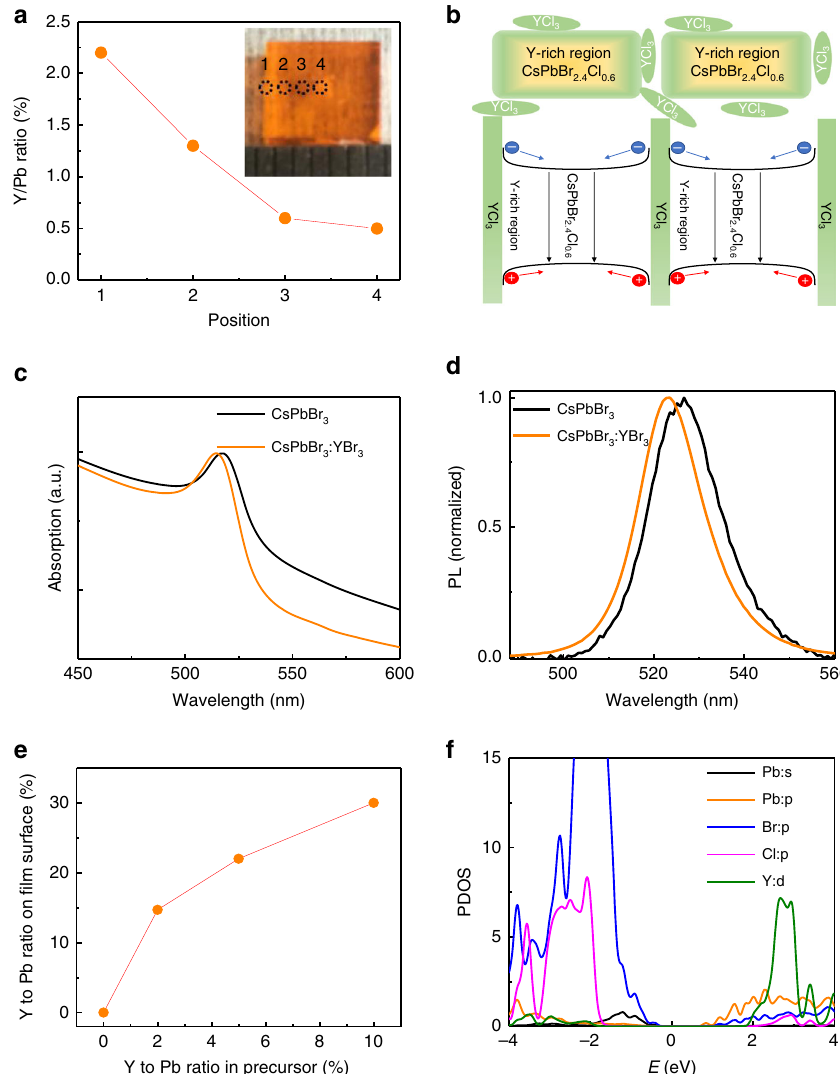
Fig. 4 Mechanism of PLQE enhancement by YCl 3 . a ICP measurement results that show the Y/Pb ratios in the different locations of the crystal. The crystal (inset) was cleaved into thin pieces (1 – 4) and Y/Pb ratio of each piece was measured. b Schematic illustration of the yttrium gradient distribution in the CsPbBr 3 :PEACl (1:1) fi lm and its function in increase the bandgap around the grain surface. Absorption ( c ) and PL ( d ) of CsPbBr 3 fi lms with or without YBr 3 . e XPS measurement results that show the Y/Pb ratios on the surface of CsPbBr 3 :PEACl (1:1) fi lms with different YCl 3 ratios of 0%, 2%, 5%, and 10%. The Y/Pb ratios on the fi lm surface is higher than the corresponding Y/Pb ratios in the precursor solutions. f DFT-calculated PDOS of CsPbBr 3 with YCl 3